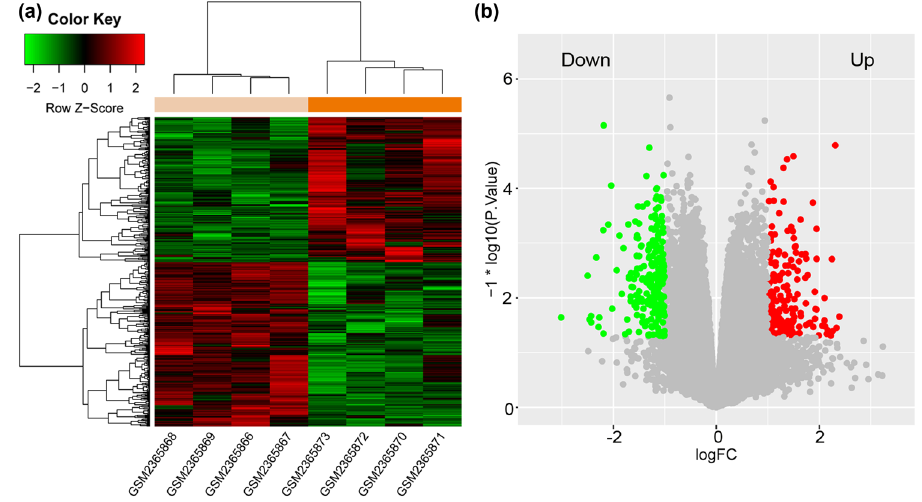
Figure 1: DEGs between ALI tissue specimens from lung - speci fi c GGPPS1 - knockout mice and wild - type mice. FC, fold change. ( a ) Bidirectional clustering heat map. ( b ) Volcano distribution